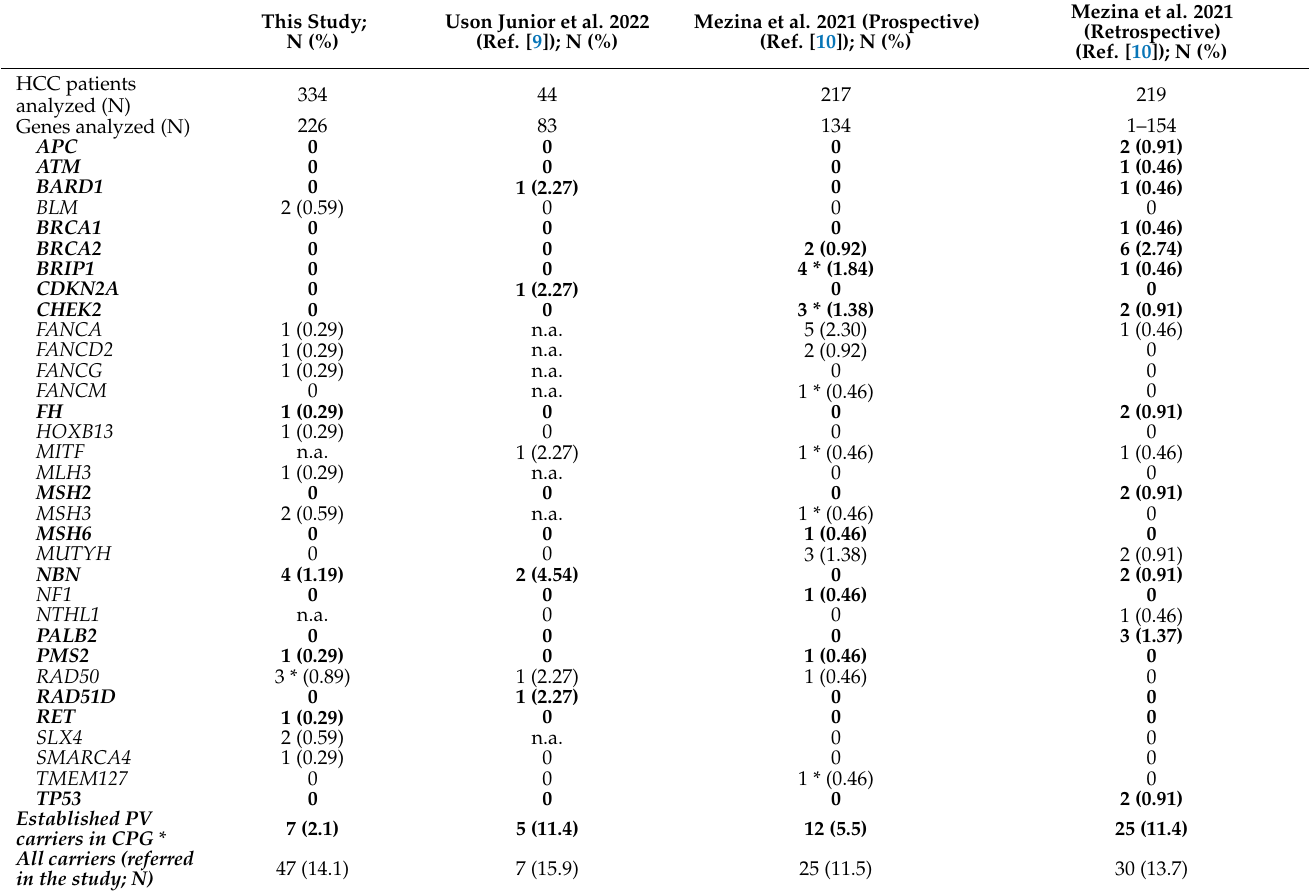
Table 4. Comparison of germline panel studies in HCC patients. The table describes only genes that were analyzed in at least two cohorts and where a carrier of heterozygous PV was found. Established high-to-moderate cancer predisposition genes are highlighted in bold